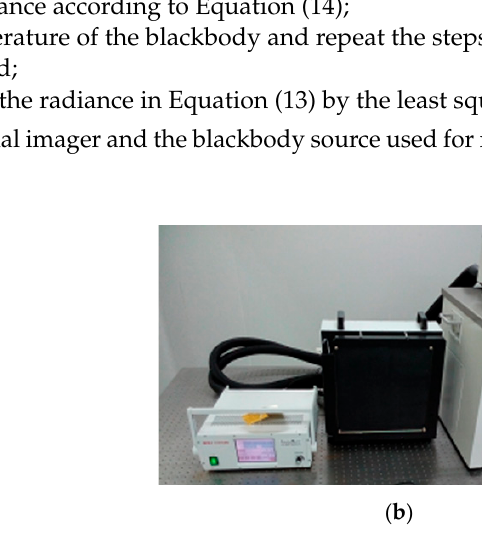
Figure 3. The infrared thermal imager and the blackbody source. ( a ) Infrared thermal imager; ( b ) Blackbody source.